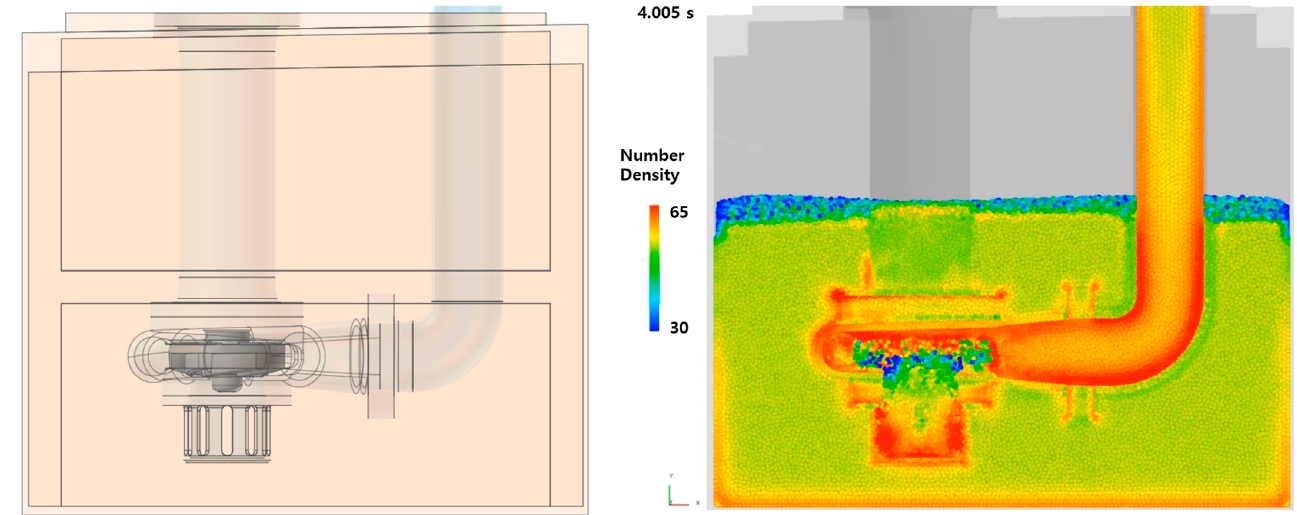
Figure 5. Before and after pump operation. (right image, 4-s section).